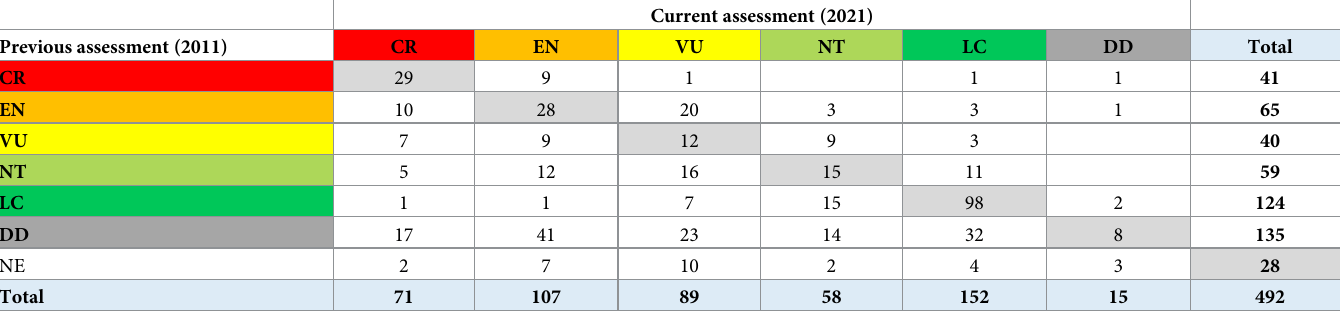
Table 4. Number of amphibian species that changed their conservation status from the previous Ecuadorian Red List [27].